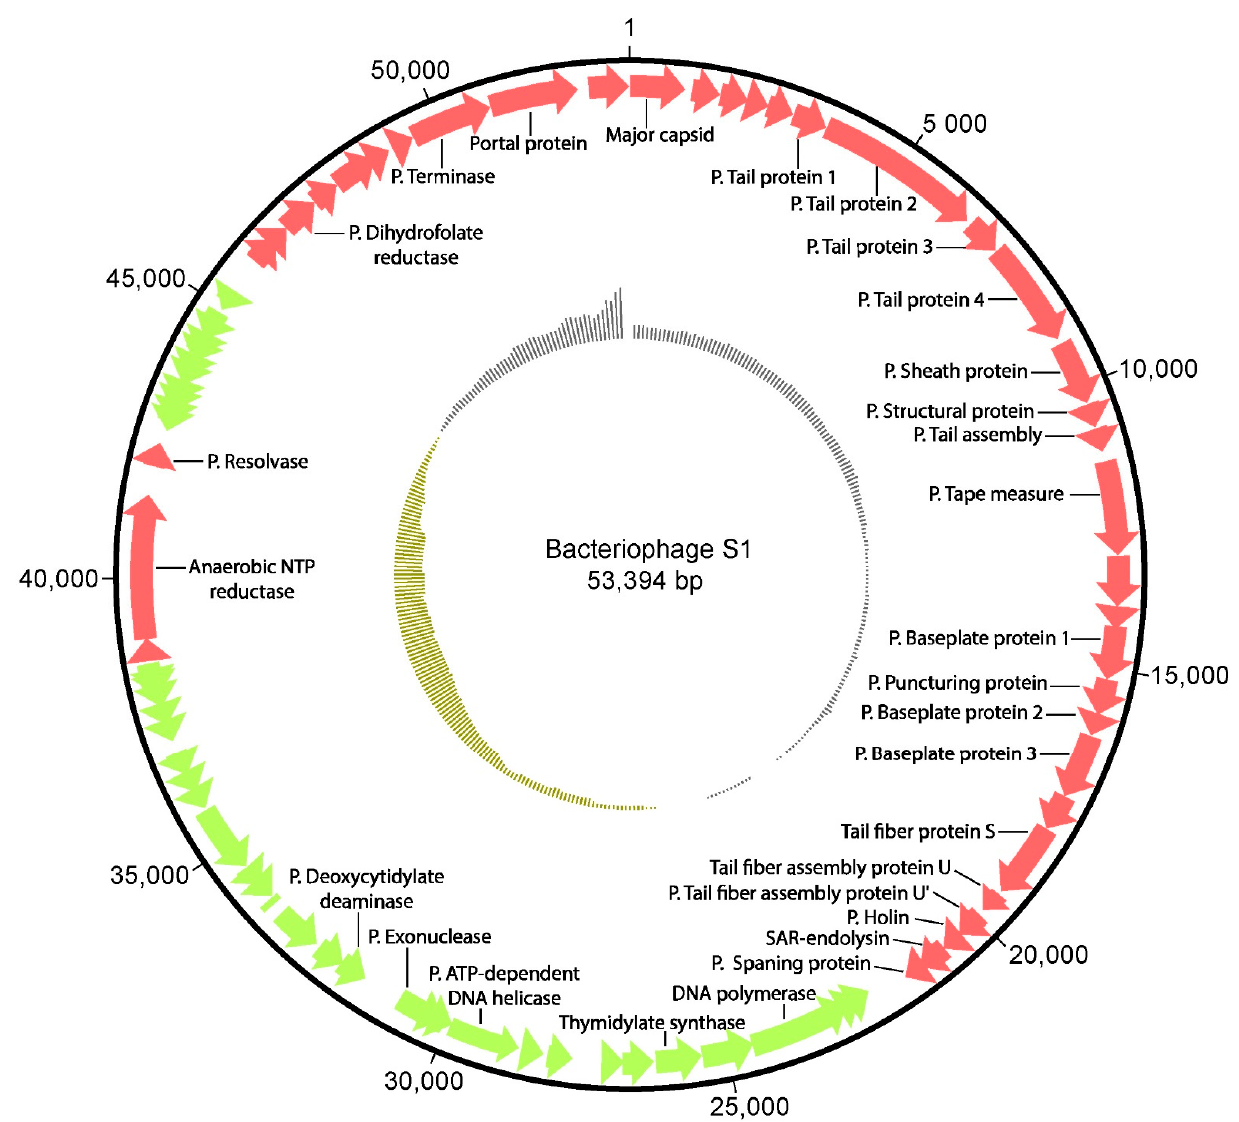
Figure 1. Genome representation of phage proteins with putative and known functions. The outside of the circle represents the positions of the protein-coding genes and arrow shows the direction they are transcribed. The inside of the cirle represents plots of the GC content.